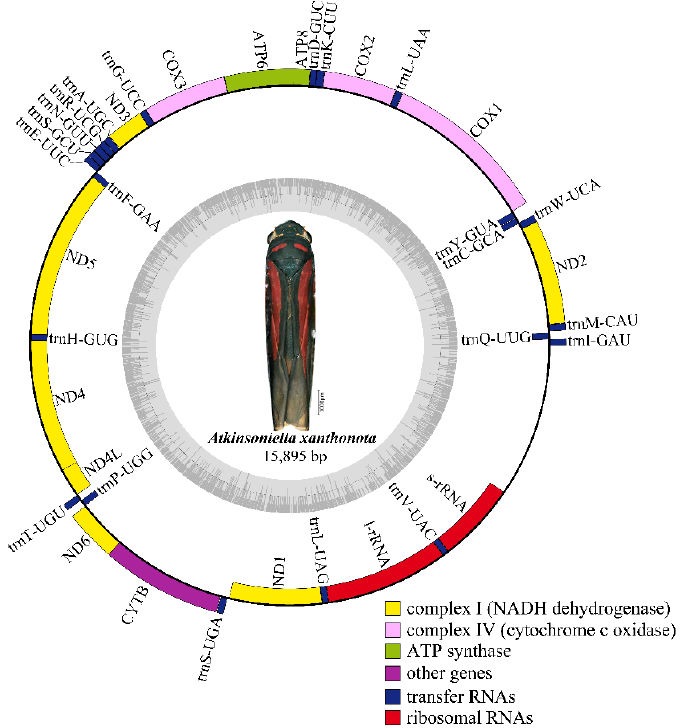
Figure 2. Circular map of the mitochondrial genome of Atkinsoniella xanthonota. Genes are represented with different color blocks. Color blocks outside the circle indicate the genes are on the majority strand (J-strand); those within the circle indicate the genes are located on the minority strand